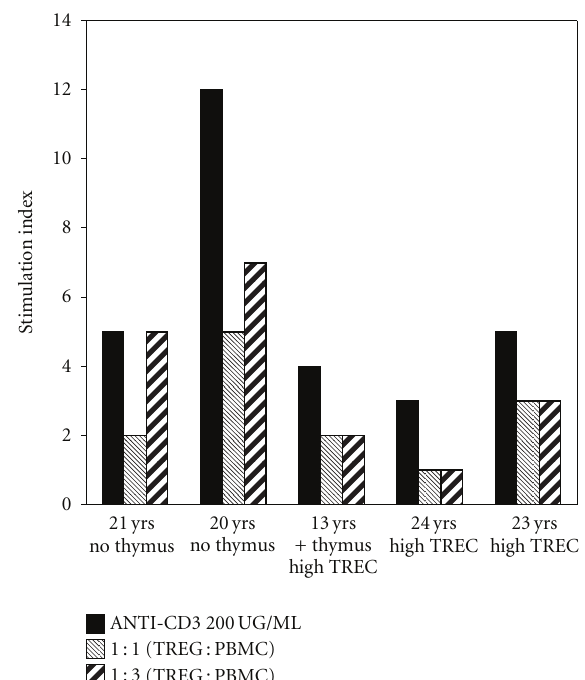
Figure 4: Lymphocyte proliferation. PBMC from 5 subjects were stimulated with 200ng/mL anti-CD3 antibody. Stimulation index (representing the mean of triplicate wells for each subject and each condition) in the presence of no added Tregs (black bars). Proliferation was suppressed by addition of Treg at a ratio 1:1 Treg to PBMC (grey bars), or at a ratio of 1:3 Treg to PBMC (hatched bars) in each